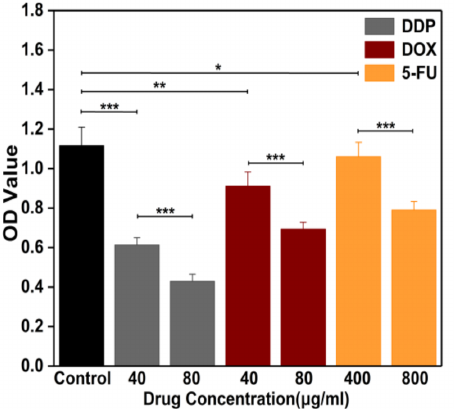
Figure 9. Proliferation of HeLa cells treated dose-dependently with DDP, DOX, and 5-FU based on the CCK-8 assay.